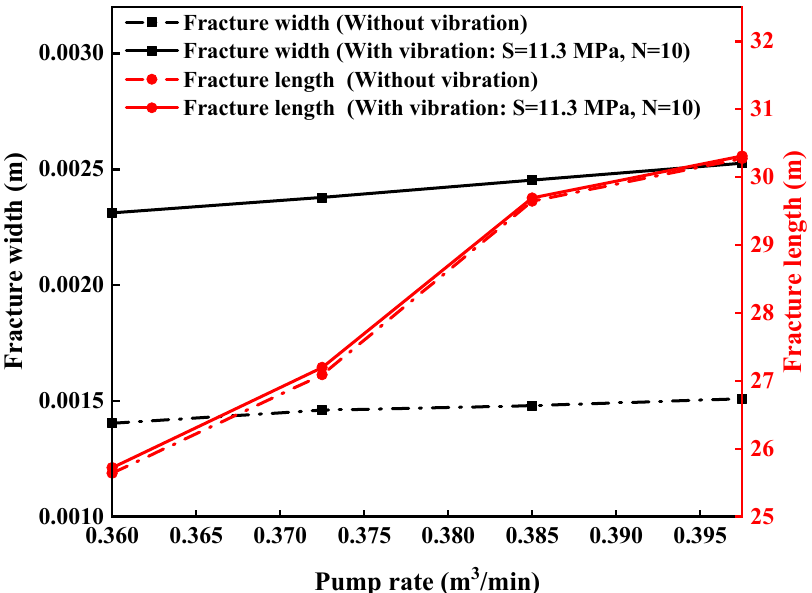
Figure 16. Effect of pump rate on fracture length and fracture width with and without vibration cyclic loads.